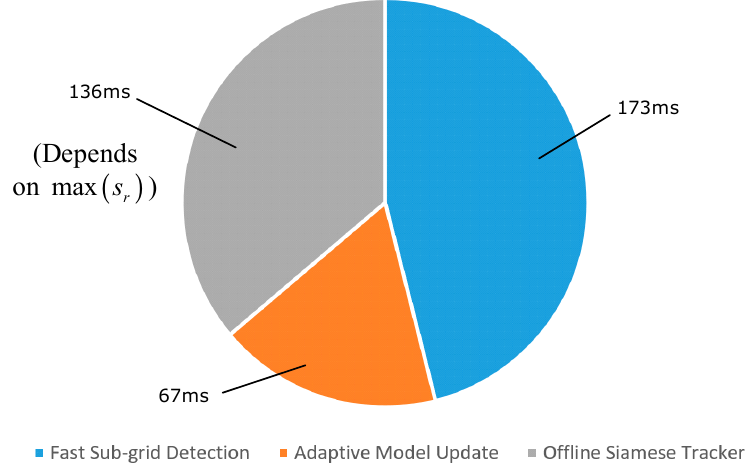
Figure 7. A single iteration processing time decomposed across the main steps of the proposed